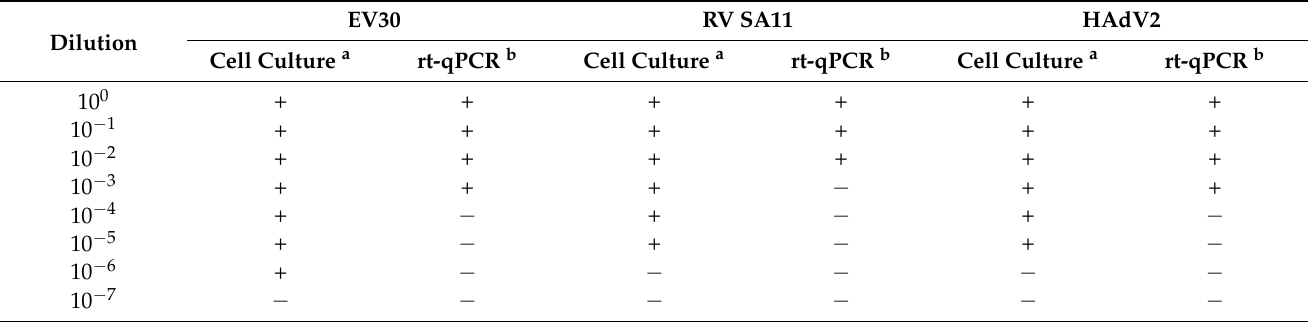
Table A2. RT-qPCR result and viral infectivity results of EV30, RV SA11, and before UV